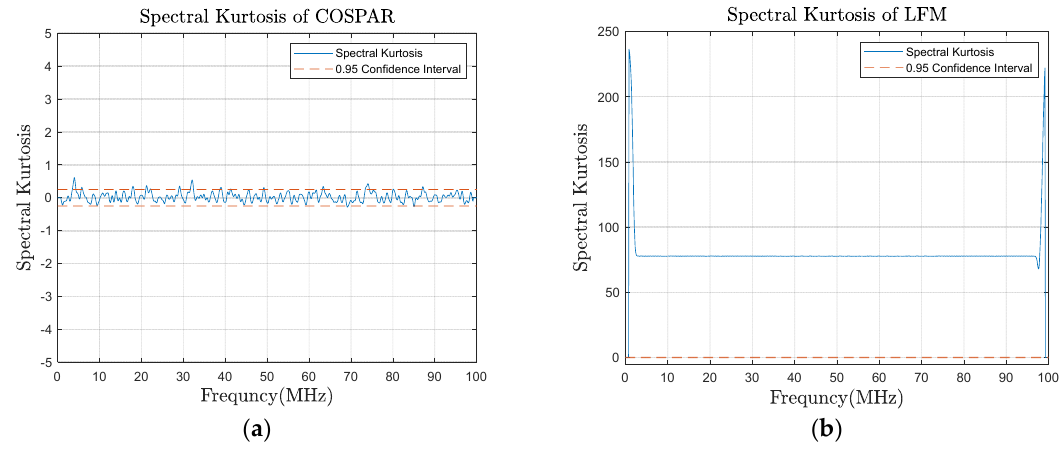
Figure 17. ( a ) Spectral Kurtosis of COSPAR signal. ( b ) Spectral Kurtosis of LFM signal.